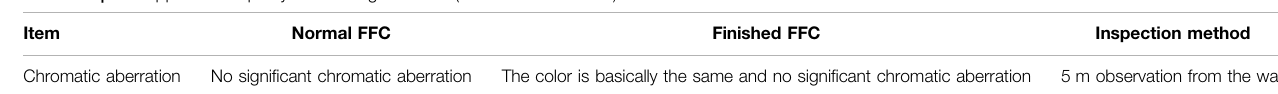
TABLE 2 | FFC appearance quality and testing methods (chromatic